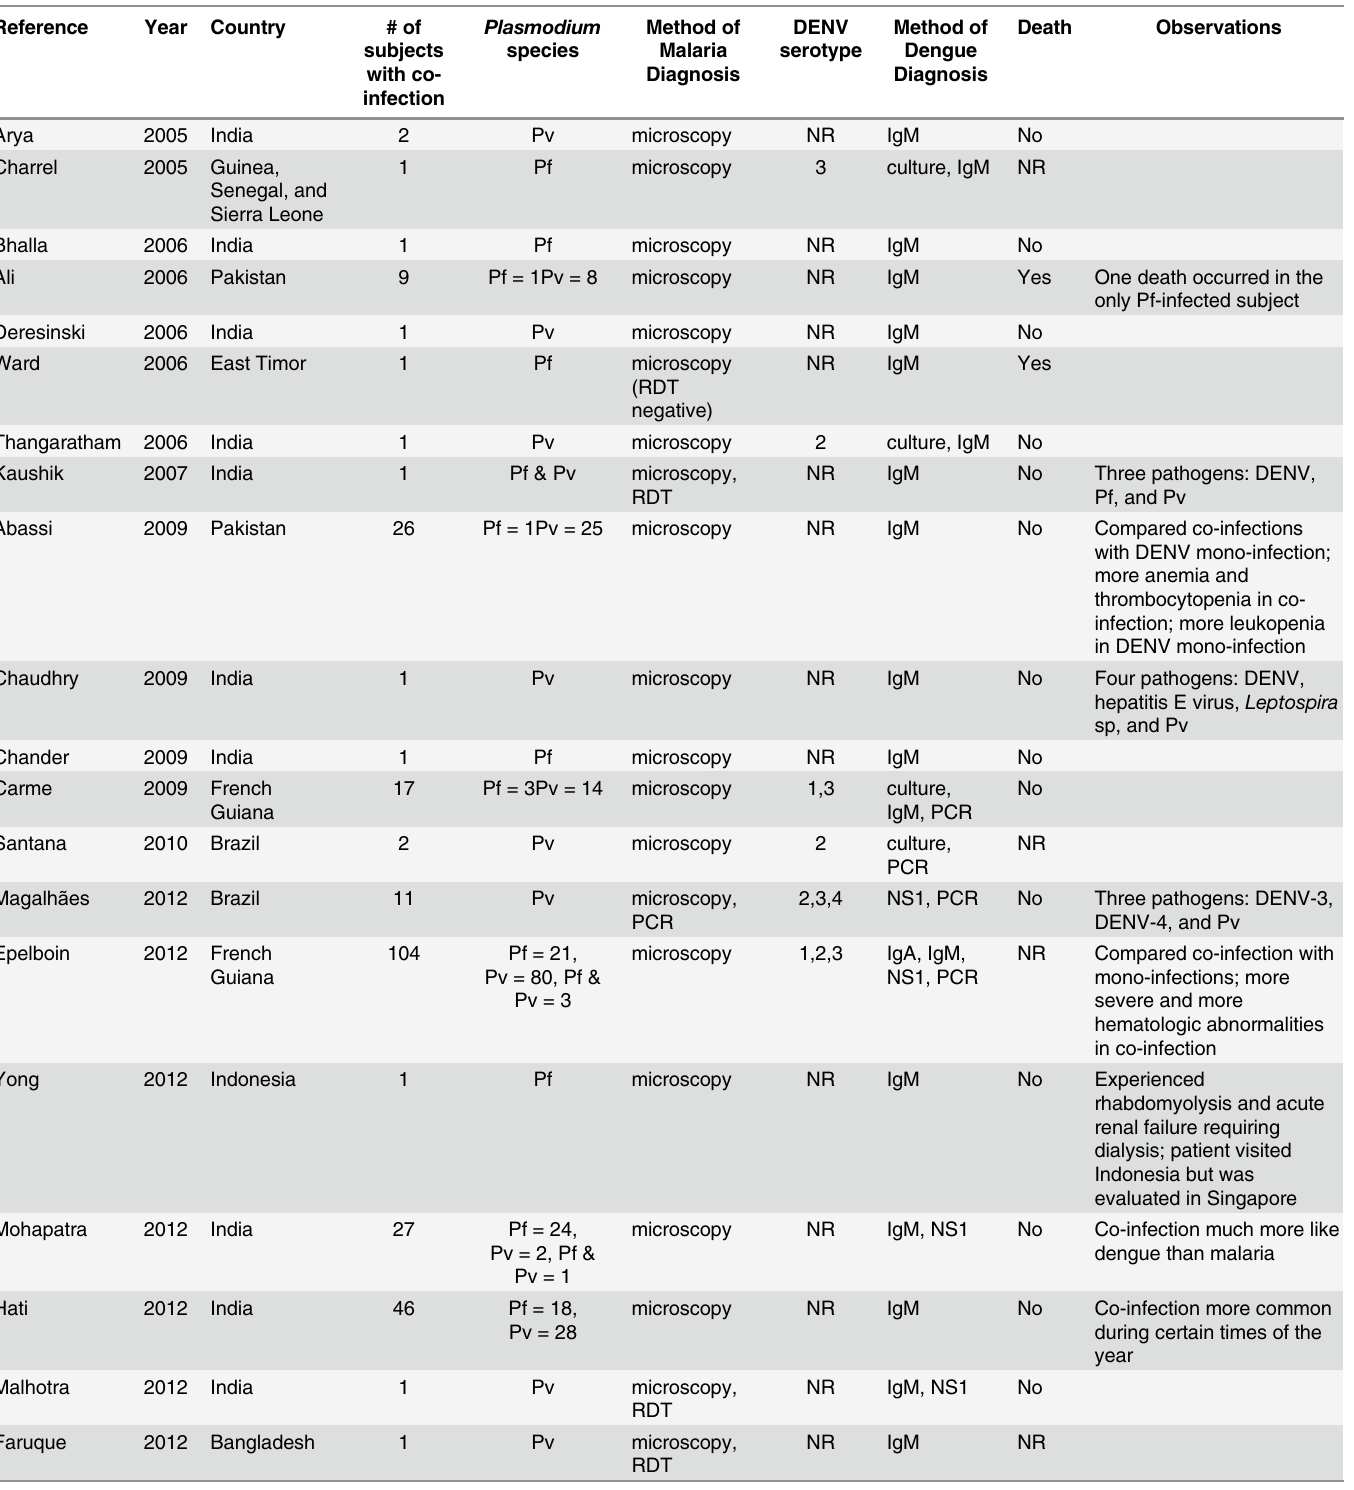
Table 1. Case reports and case series of co-infection with Plasmodium and dengue virus. Reference